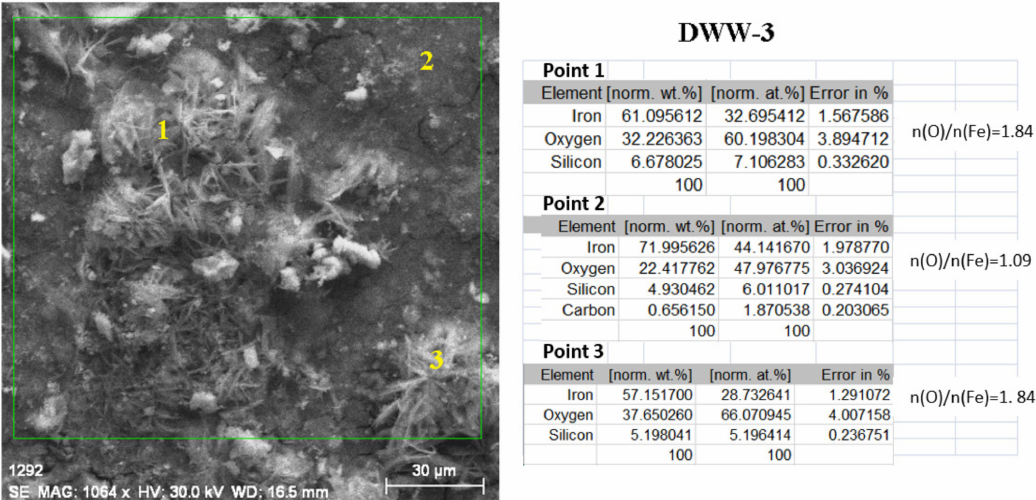
Figure 14. Punctual EDS microanalysis of the sample surface immersed for 30 days in DWW-3.